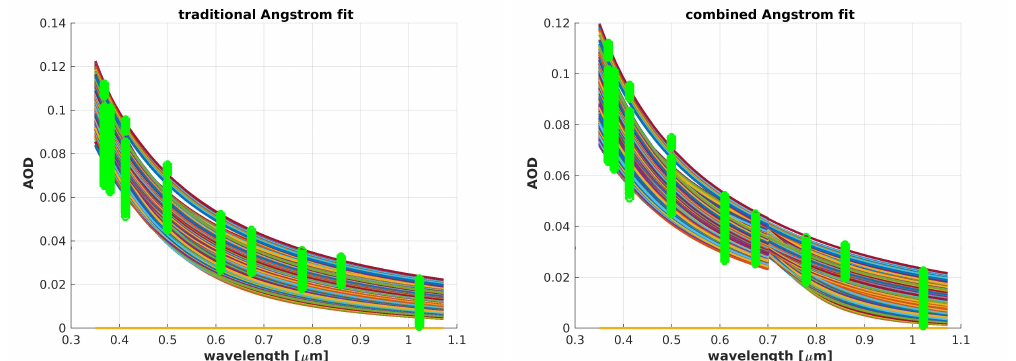
Figure 1. Green circles are individual measurements, the colored lines the fitted exponential law. Left: The data were fitted with the traditional Ångström law of Equation (1). Right: Equation (2) with two wavelength ranges of the UV and visible (<700 nm) and the near-infrared (>700 nm) were used for the same